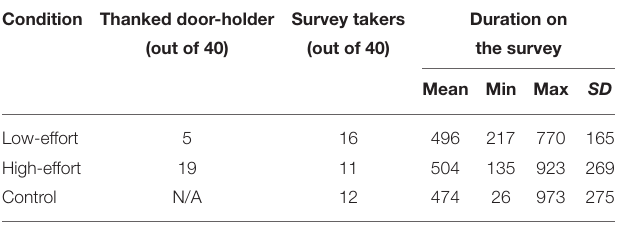
TABLE 1 | Number of survey takers and how long they spent (in seconds) on the survey for each condition. Condition Thanked door-holder Survey